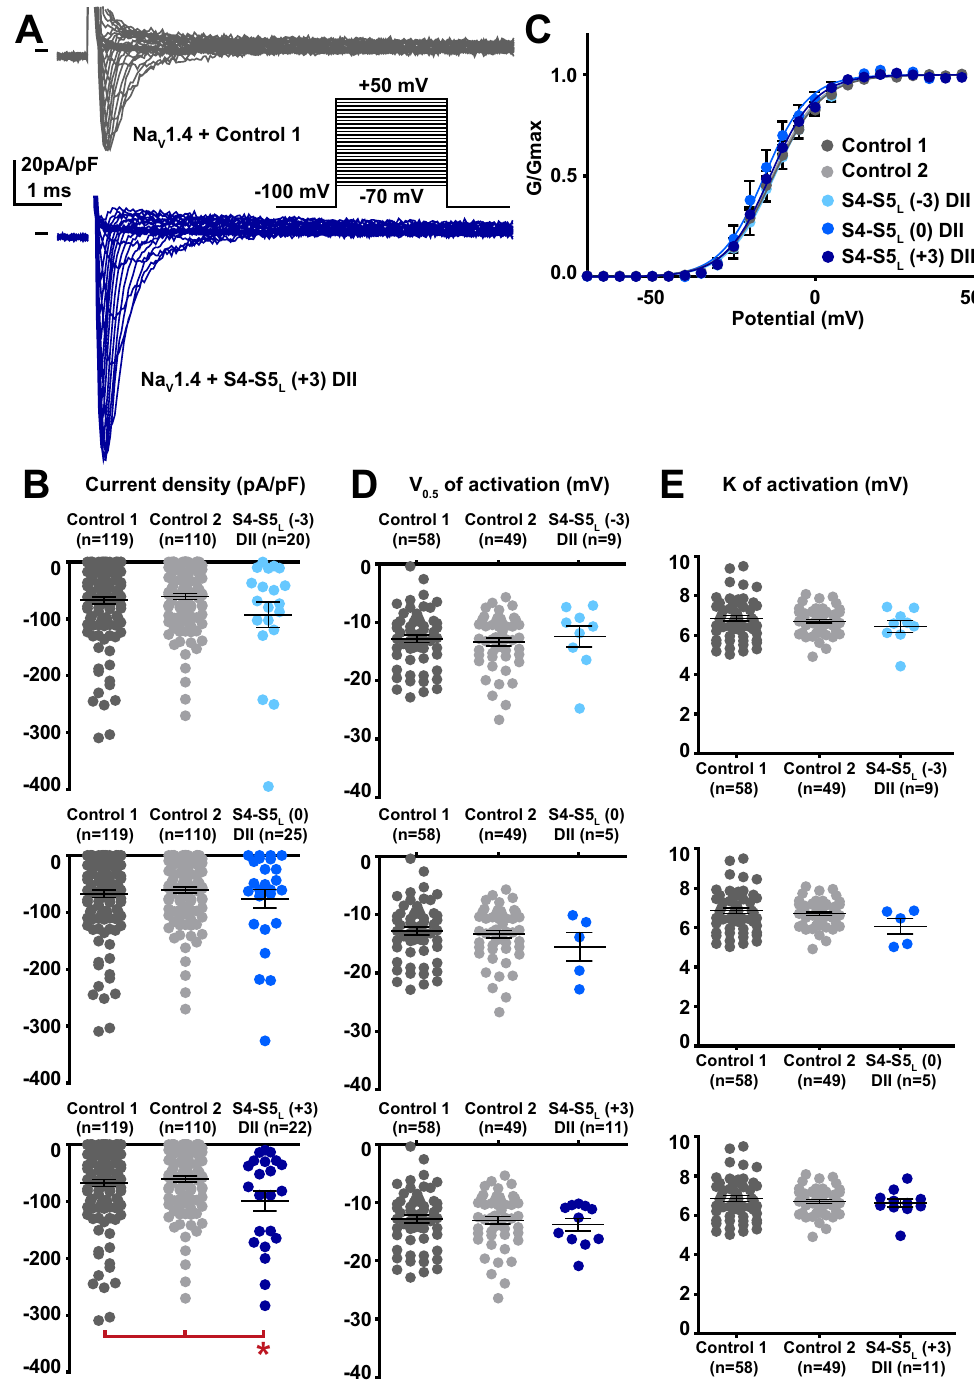
Figure 6. Effect of Na V 1.4 S4-S5 L mimicking peptides of domain II on Na V 1.4 current density and activation curve. ( A ) representative, superimposed current recordings in COS-7 cells co-transfected with Na V 1.4, Na V ß1, and control 1 (top trace) or domain II S4-S5 L ( + 3) peptide (bottom trace). Inset: activation voltage protocol used (holding potential: − 100 mV; 30-ms pulse; one sweep every 2 s). ( B) Dot plot and mean ± sem of peak Na V 1.4 current densities recorded in COS-7 cells co-transfected with Na V 1.4, Na V ß1, and the indicated peptide, at 0 mV. ( C ) Relative peak conductance versus membrane potential curves for Na V 1.4 channels in the same cell groups as in ( B) . Lines are Boltzmann fits to the data. ( D , E) Dot plot and mean ± sem of Na V 1.4 half-activation potential (V 0.5 ; D ) and activation slope (K; E ) in the same cells group as in ( B) . * p value vs . both controls <